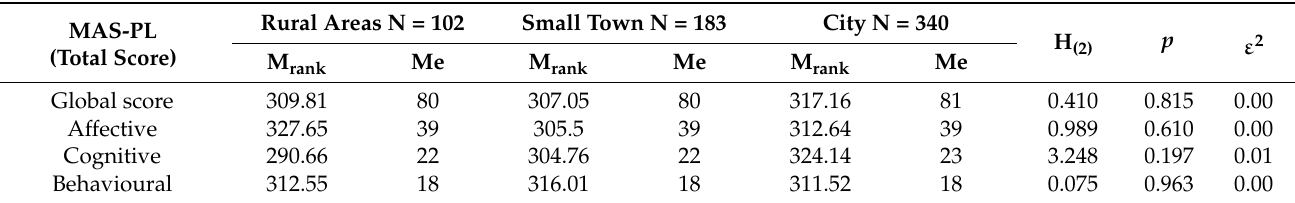
Table 4. Assumption of Kruskal–Wallis H tests of the results of MAS-PL scores (total score, affective, cognitive, and behavioural subscales): by place of residence (N = 625).